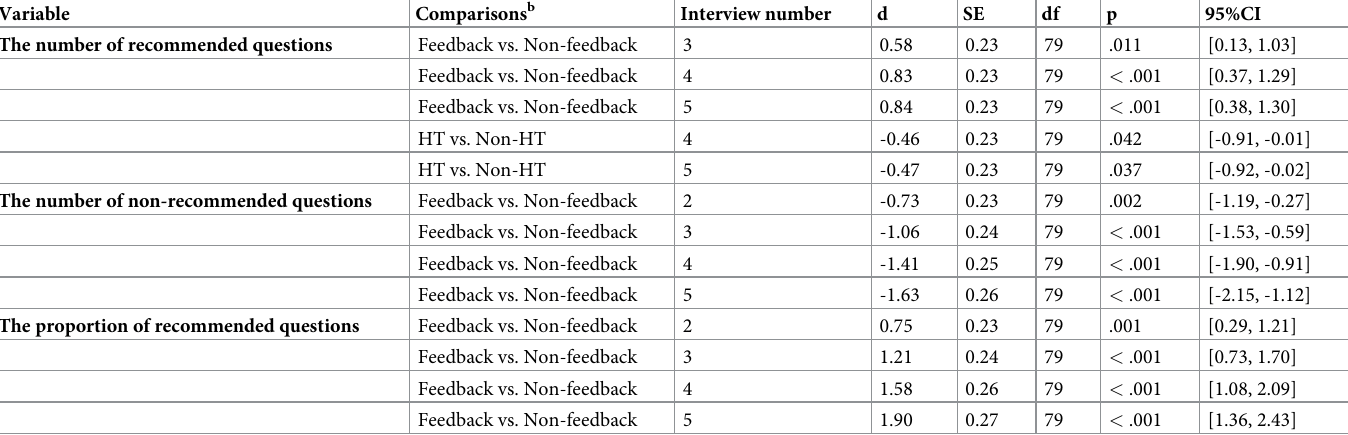
Table 3. a The individual effect of the HT or feedback intervention on the types of questions over time.